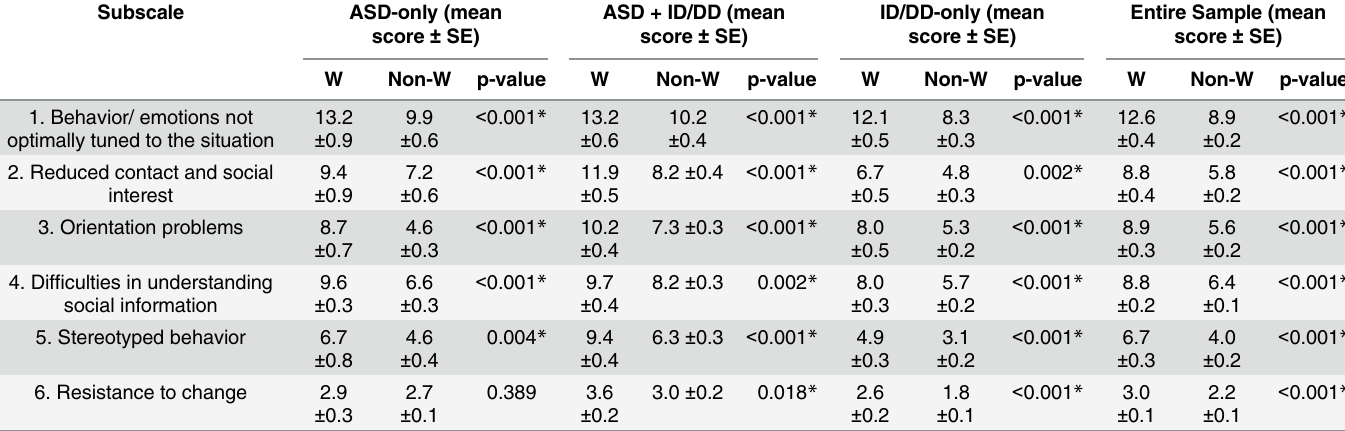
Table 5. Comparison of CSBQ Subscale Scores between Wanderers and Non-wanderers.